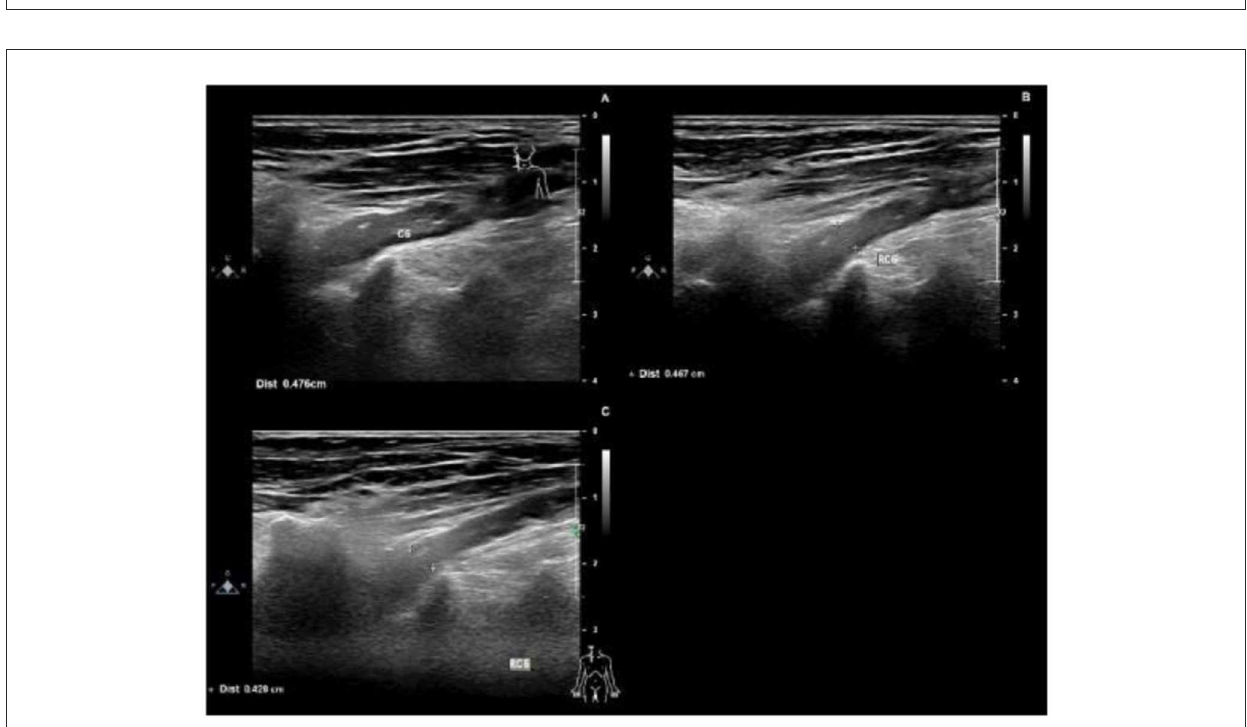
FIGURE2 Ultrasounds 4 months after the onset of the disease, the right C6 nerve root was thickened, with a thickness of 0.476cm (A) . 6 months after the onset of the disease, the right C6 nerve root was thickened, with a thickness of 0.467cm (B) . 11 months after the onset of the disease, the right C6 nerve root was thickened, with a thickness of 0.426cm (C)